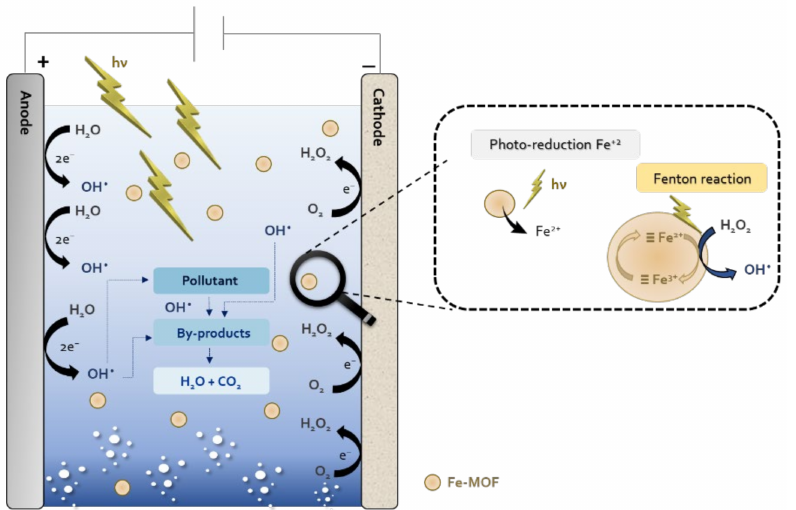
Figure 11. Schematic representation of the photo-electro-Fenton process with Fe-MOF as suspended heterogeneous